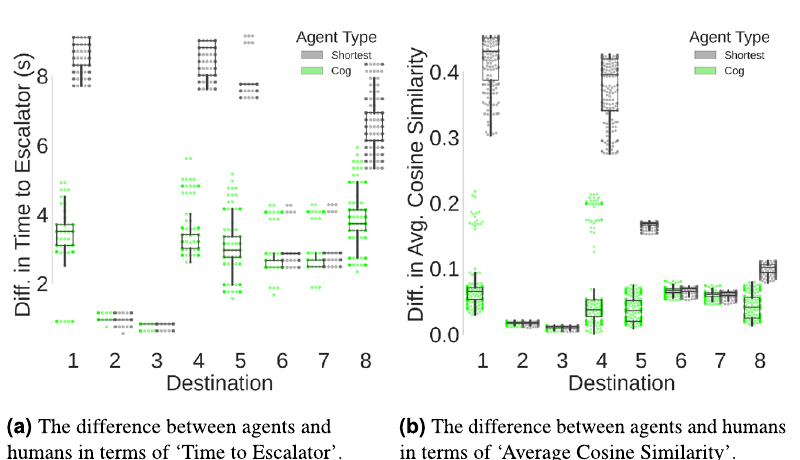
Figure 6. Differences between agents and humans in terms of three wayfinding behavioral metrics. Software used to create this figure: Python 34 (version 3.5.8), https:// www. python. org/ downl oads/ relea se/ python- 358/; Seaborn 35 (version 0.11.1), https:// seabo rn. pydata. org/ index. html; Matplotlib 36 (version 3.3.2), https:// matpl otlib. org/3. 3.2/ users/ insta lling.